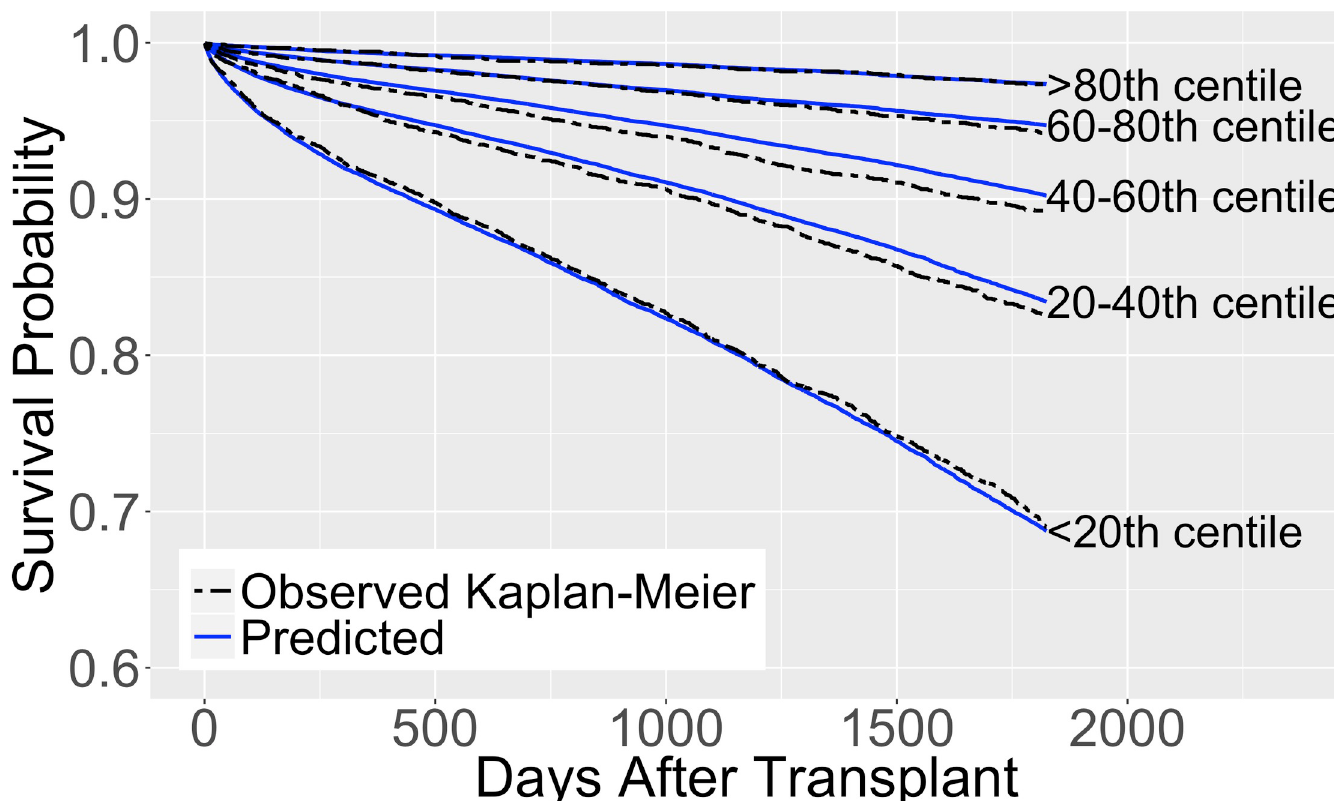
Fig 5. Predicted survival of the proposed model. Trained on 100,000 observations and validated on 25,000 out-of-sample observations. The survival curves are separated into 5 groups based on the predicted 5-year survival in the out-of-sample data.